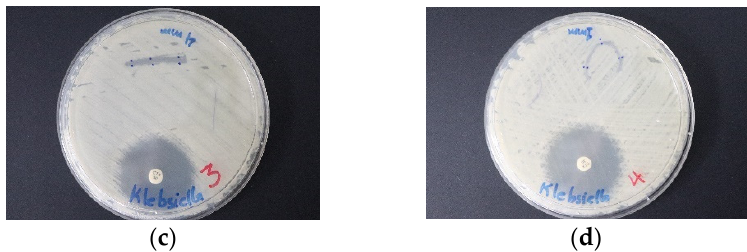
Figure 12. Antimicrobial agar plate methods on dip coated PGA sutures with positive control antibiotic cefotaxime against K. pneumoniae WDCM 00097 . From left to right: ( a ) Cinn-AgNP-PI; ( b ) TCA-AgNP-PI dip-coated PGA; ( c ) TCA-AgNP; ( d ) Cinn-AgNP-PI.